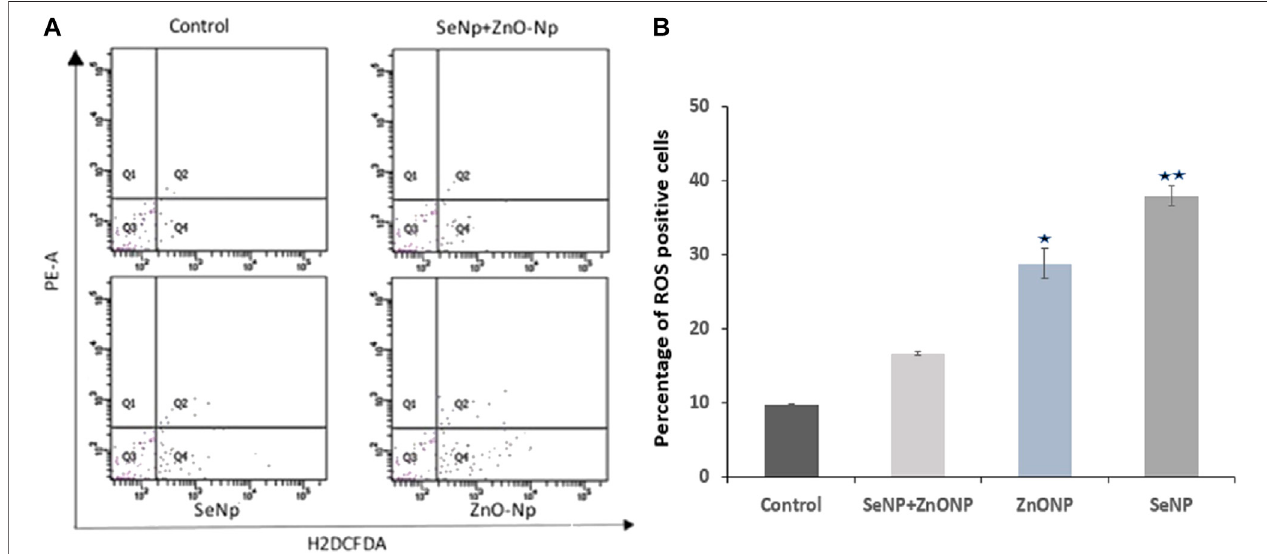
FIGURE 3 | Intracellular ROS analysis in adult zebra fi sh using fl ow cytometry: (A) Q4 represents the intracellular ROSlevel measured by H2DCFDA fl uorescence dye. (B) Bar graph showing the percentage of ROS + cells (Q4 quadrant of the fl ow cytometric graph) in the four different groups. Signi fi cantly low mean value ± SD of ROS+cellswerefound( p < 0.05)inbothZnONP andSeNP groupscompared tocontrolandZnONP +SeNPgroups.* p < 0.05denotesigni fi cantvariationfrom control embryos as obtained by ANOVA analysis.